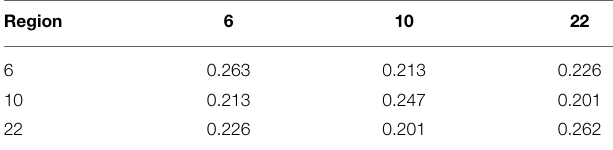
TABLE 2 | CP similarities for different classifications using the Cramer coefficient in the regions numbered 6, 10, and 22 in Figure